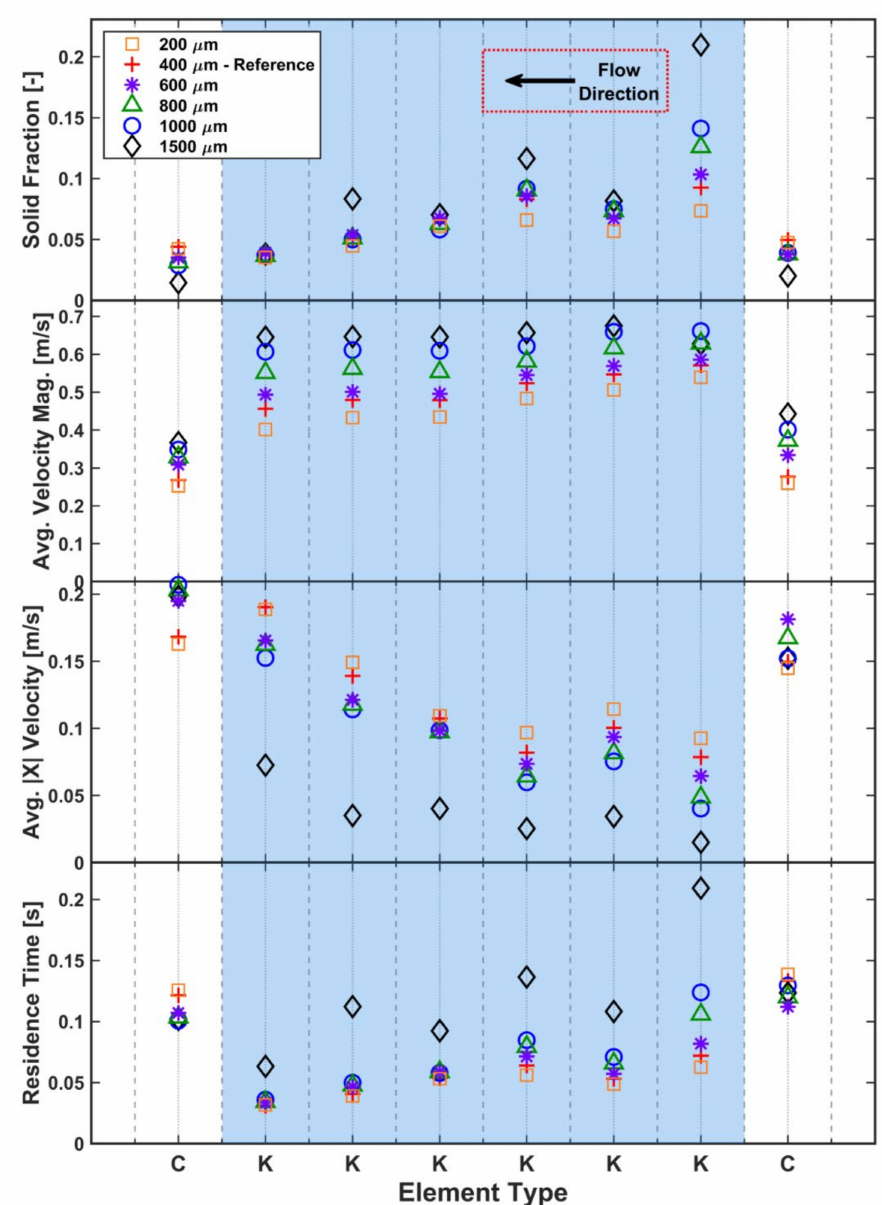
Figure 10. Effect of particle size on solid fraction, velocity and residence